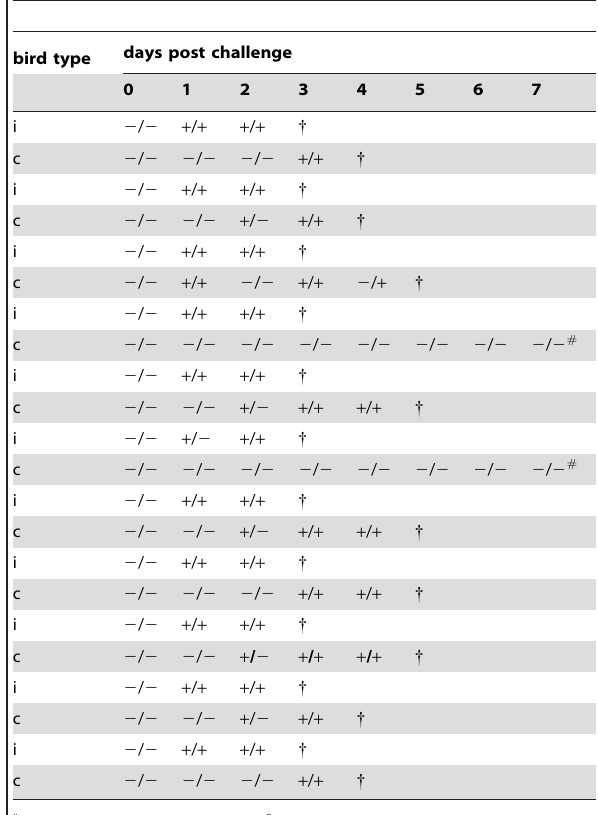
Table 1. Overview of the transmission experiment with unvaccinated birds (low infection